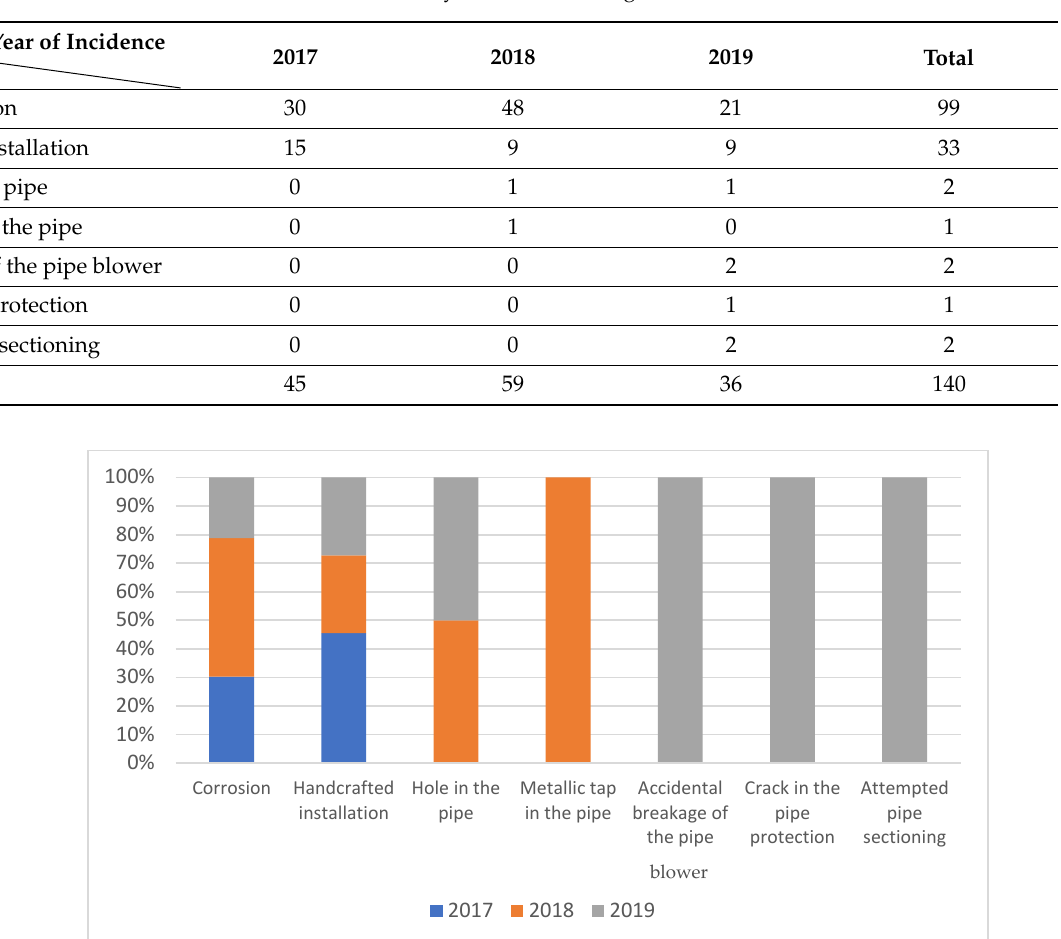
Table 6. The cross-tab for cause and year of incident registration.